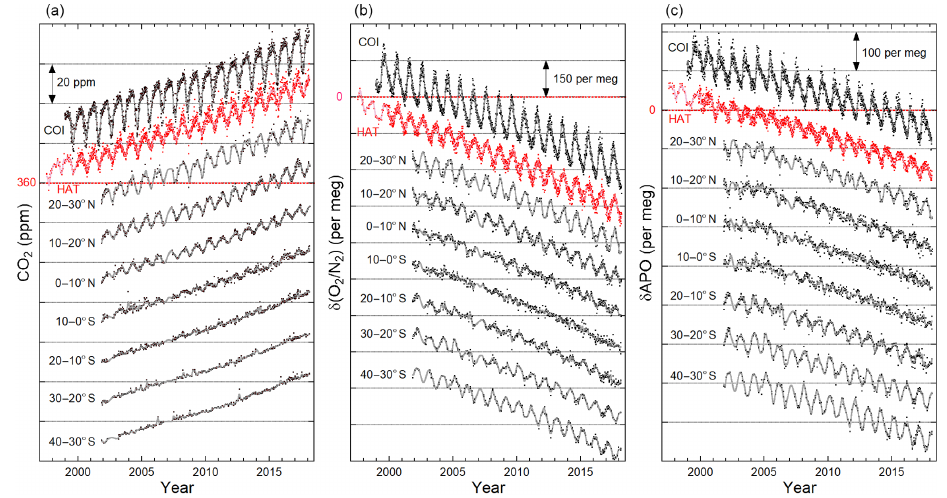
Figure 5. Time series of the atmospheric CO 2 mole fraction (a) , O 2 / N 2 ratio (b) and APO (c) of the flask samples obtained from the NIES flask sampling network shown in Fig. 1. Observed data from COI, HAT and cargo ships operating between 40 ◦ S and 30 ◦ N were used for the global carbon budget calculation. The time series of CO 2 , O 2 / N 2 and APO are offset by 20ppm, 150 per meg and 100 per meg, respectively, to allow them to be plotted on the same panels. The numbers on the y axis represent the values for the data at